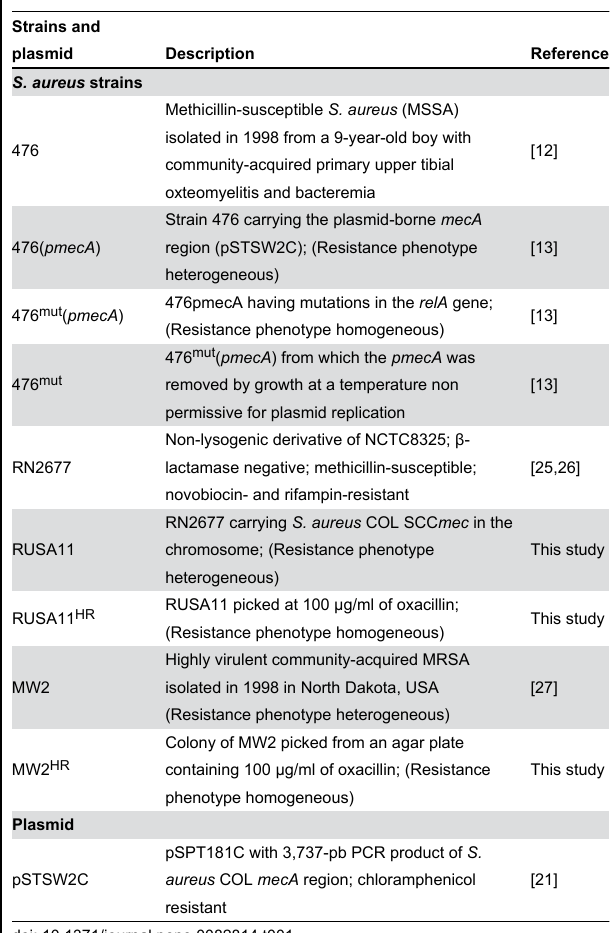
Table 1. Strains and